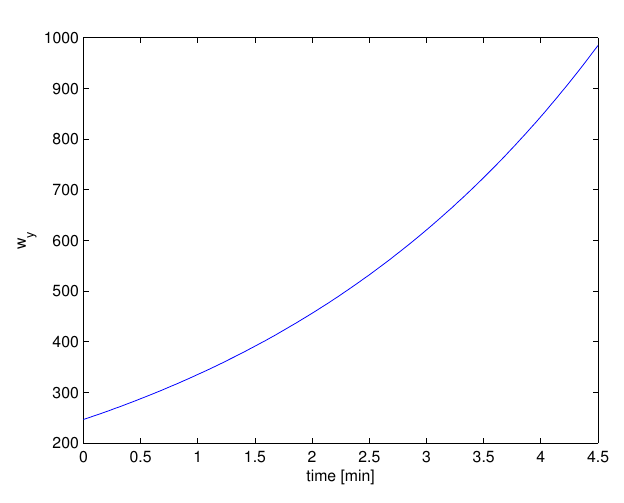
Figure 7. Reference signal minimizing J 1 .